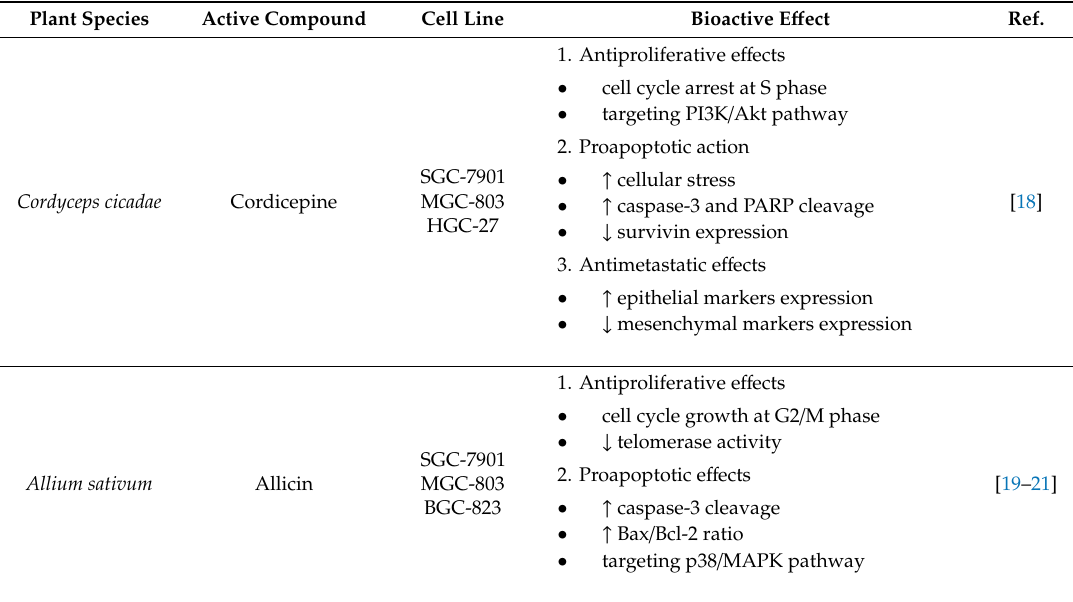
Table 1. The identity of the described plant species with their anticancer properties against the gastric